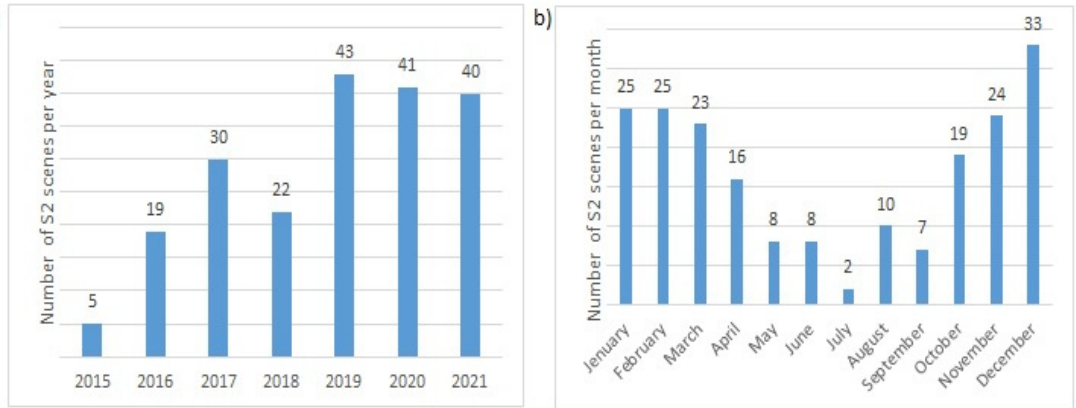
Figure 3. S2 scenes with a cloud cover threshold below 10% used to train the random forest ( a ) per year and ( b ) per month.